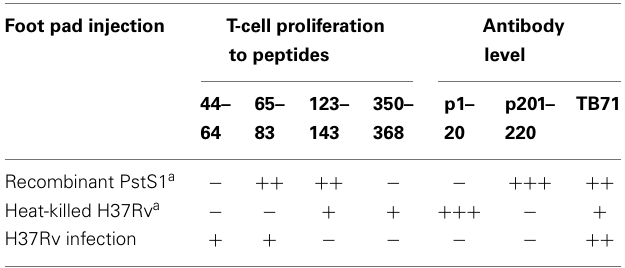
Table 3 | Differences in epitope recognition between immunized and infected C57Bl/10